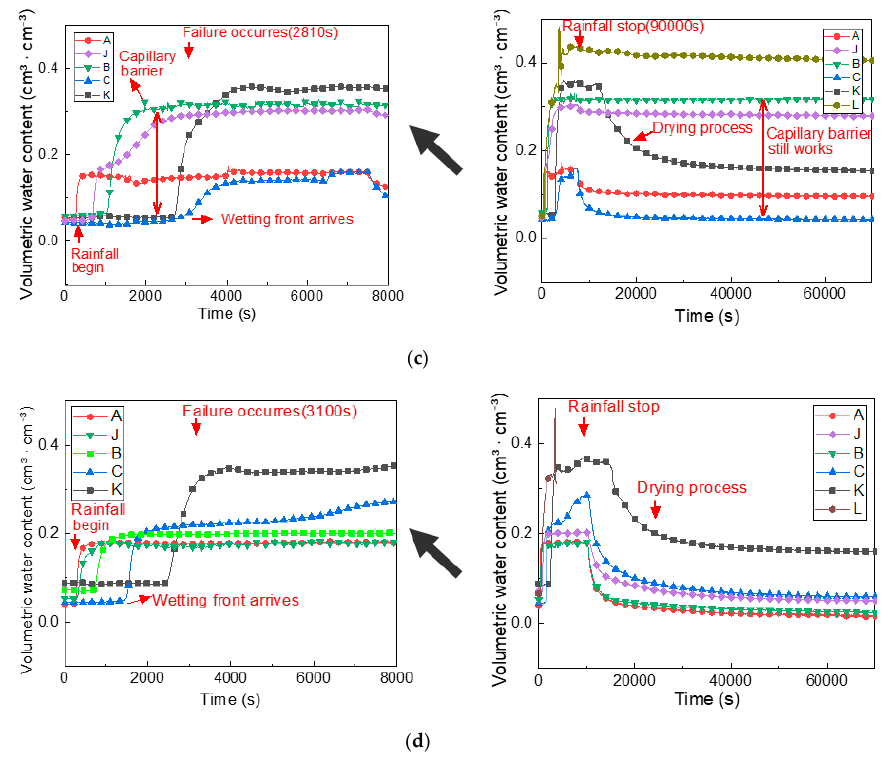
Figure 8. Time histories of VWC during rainfall and the drying process in case I, III, V, and VII (the left figures show the time from 0 to 8000 s, while the right figures show the whole wetting and dry process in the rainfall event). ( a ) Case I. VWC trends in a multi-layer slope in the flat group (tilt angle α = 0°); ( b ) Case V. VWC trends in a single-layer slope in the flat group (tilt angle α = 0°); ( c ) Case III. VWC trends in a multi-layer slope in the inclined group (tilt angle α = 15°); ( d ) Case VII. VWC trends in a multi-layer slope in the inclined group (tilt angle α = 15°).